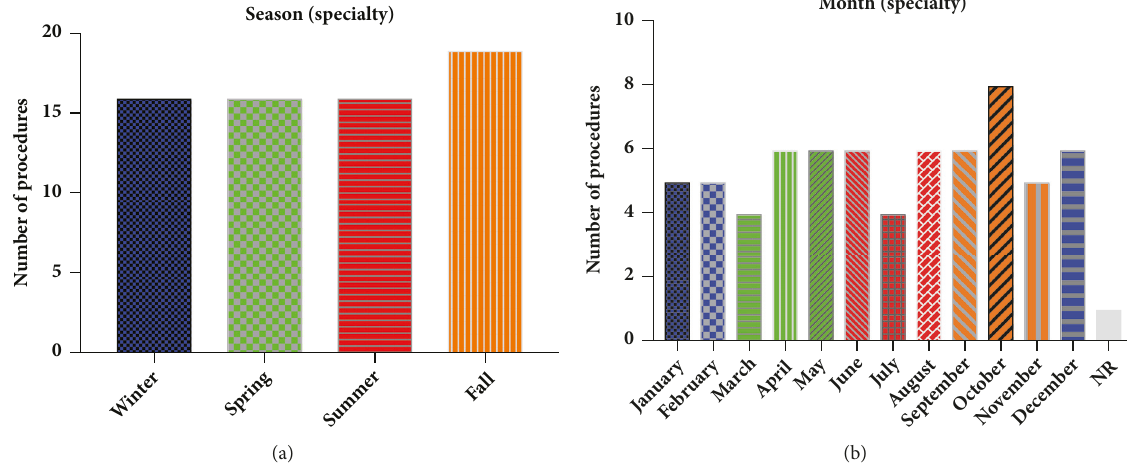
Figure 4: No trends in seasonality nor procedure month at dedicated orthopaedics hospital . (a) The season during which procedures resulting in PJIs at the dedicated orthopaedics specialty hospital were performed is shown. (b) The particular month during whichprocedures resulting in PJIs at the dedicated orthopaedics specialty hospital were performed is shown, with the months color-coded corresponding to the